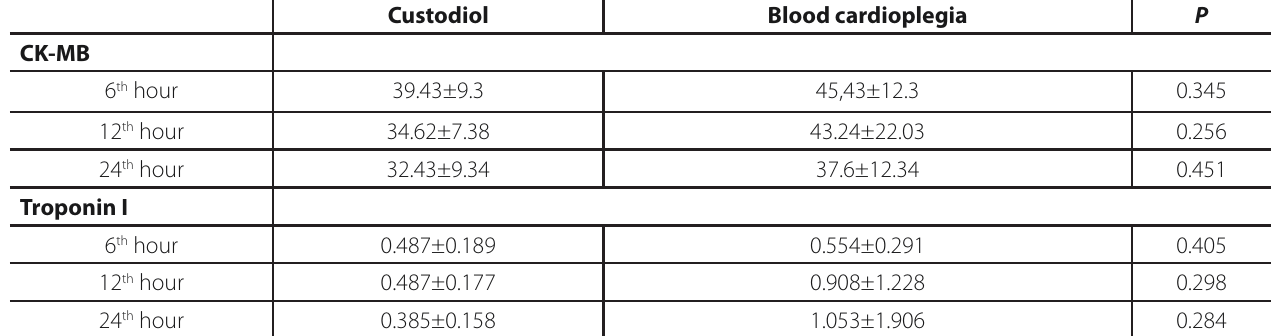
Table 4. Comparison of cardiac enzymes in the postoperative 6 th , 12 th and 24 th